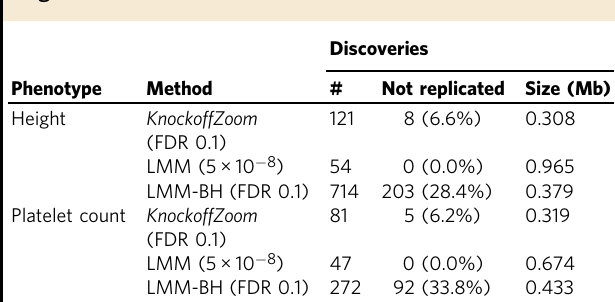
Table 2 Reproducibility of the low-resolution